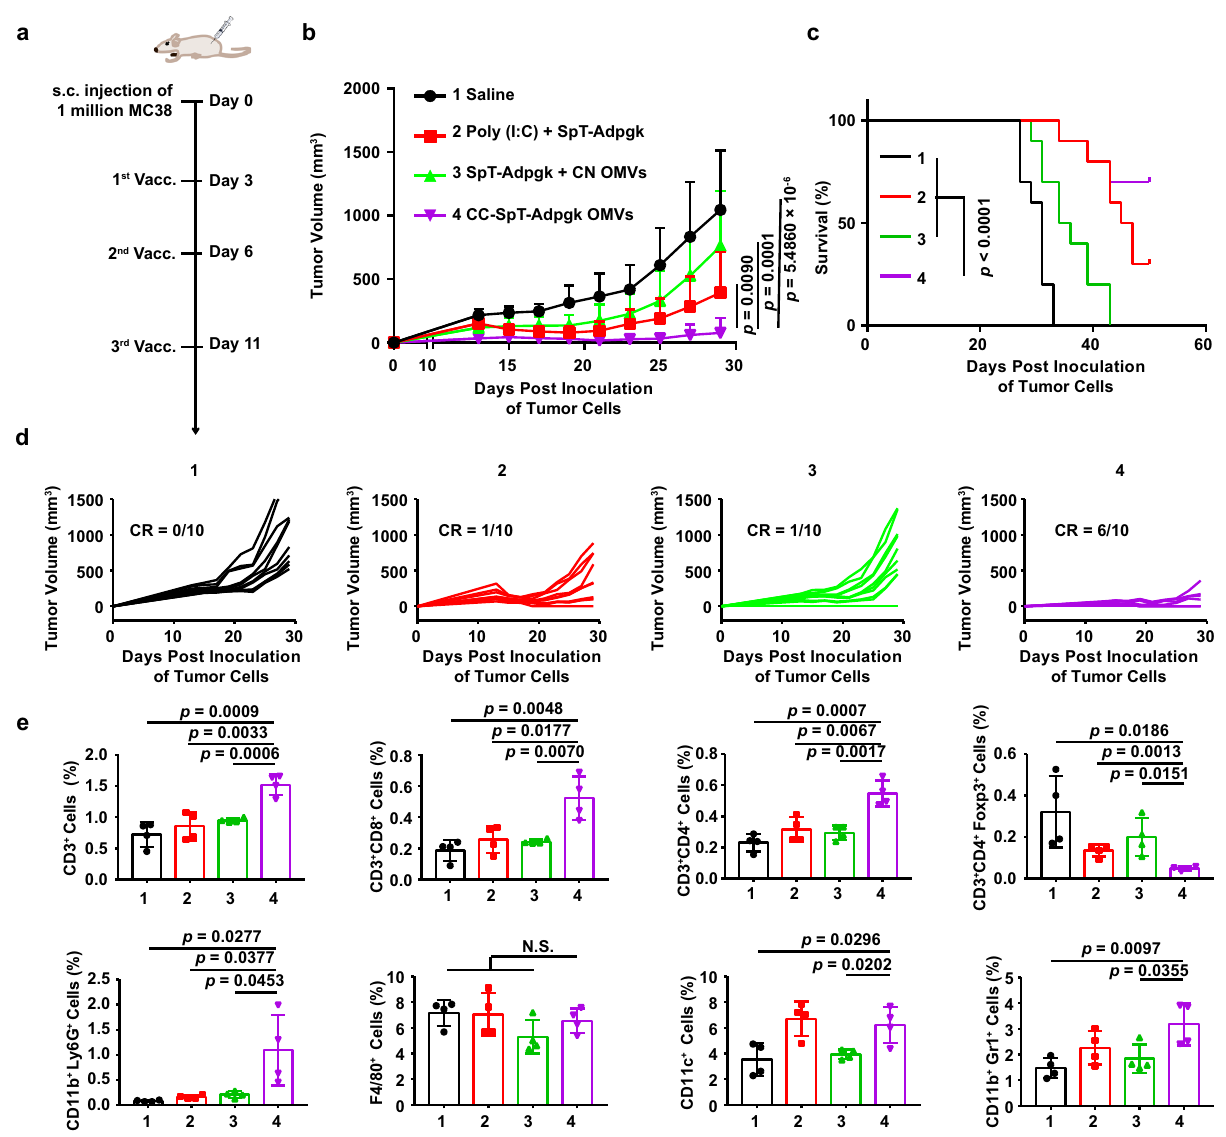
Fig. 7 The anti-tumor immunity of the antigen-displayed OMVs in the subcutaneous MC38 tumor model. The SpT-labeled Adpgk (a neoantigen in MC38 cells), SpT-Adpgk was displayed by CC OMVs (CC-SpT-Adpgk OMVs). The adjuvant Poly (I:C) and CN OMVs were used as a control to mix with SpT-Adpgk, respectively (Poly (I:C) + SpT-Adpgk and SpT-Adpgk + CN OMVs). a Schema showing the subcutaneous tumor model utilizing MC38 cells and the timing of vaccination (Vacc.) with different formulations. C57BL/6 mice were inoculated with MC38 cells (1 × 10 6 cells/mouse, s.c.) and immunized with the indicated formulations on days 3, 7, and 11. b – d Tumor volumes were recorded, and survival was monitored. The data are shown as mean ± SD ( n = 10). e In another set of MC38 tumor-bearing animals, tumors were harvested on day 29 for fl ow cytometry analysis ( n = 4) of the following immune cells: CD3 + , CD3 + CD8 + , CD3 + CD4 + , CD3 + CD4 + Foxp3 + T lymphocytes, activated neutrophils (CD11b + Ly6G + cells), macrophages (F4/80 + cells), dendritic cells (CD11c + cells), and MDSCs (CD11b + Gr1 + cells). The data are shown as mean ± SD. Statistical analysis was performed by two-tailed unpaired t test ( b , e ) and two-sided log-rank test ( c ). N.S. no signi fi cance. Source data are provided as a Source Data fi